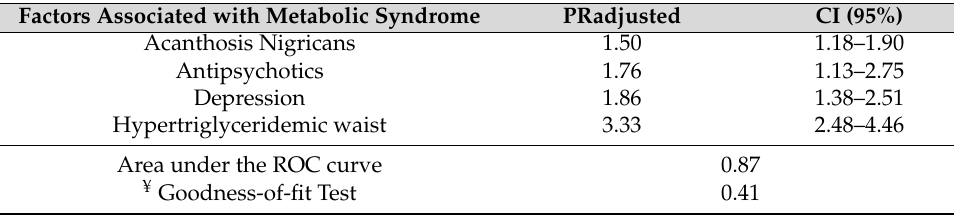
Table 4. Factors associated with MS and obtained through multivariate analysis among the users of a